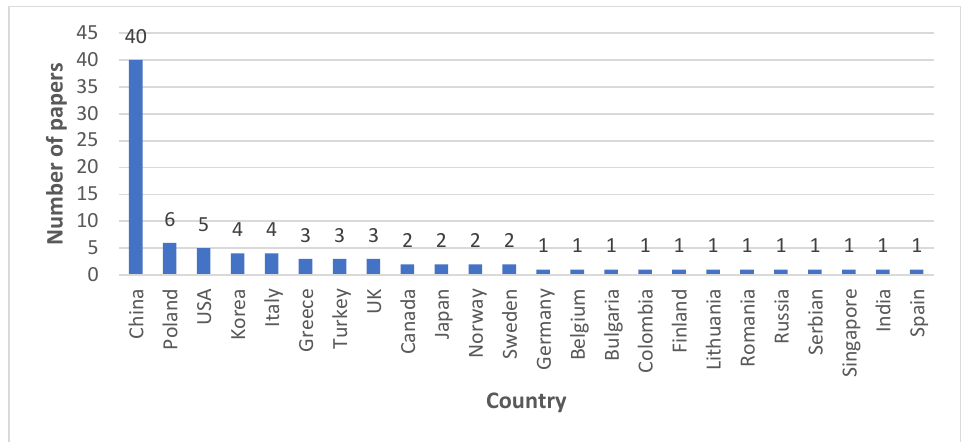
Figure 2. Country distribution of the selected articles.